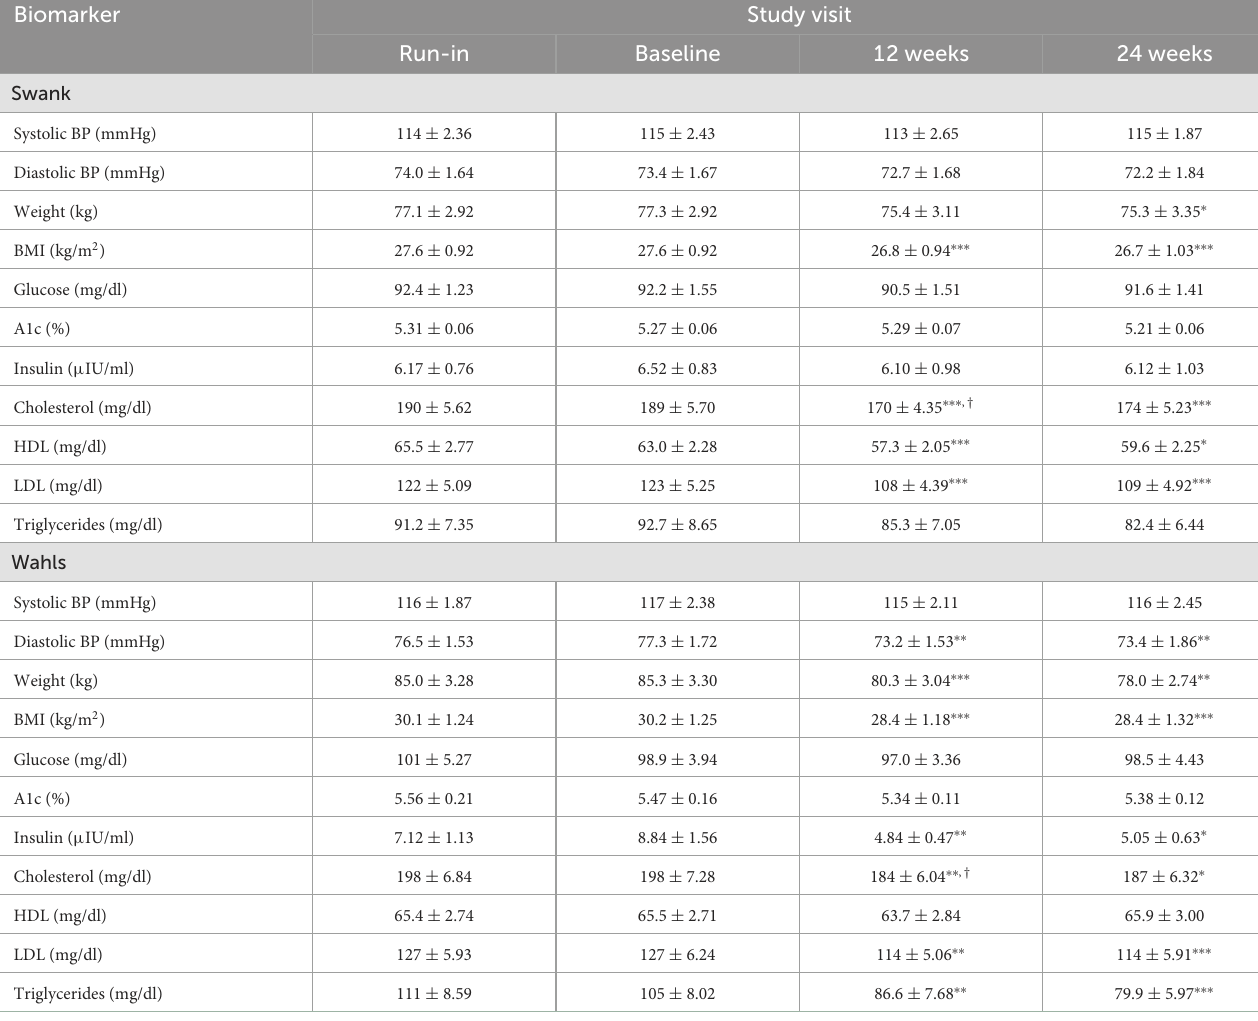
TABLE 2 Metabolic risk factor values among participants with RRMS assigned to the Swank or Wahls dietary interventions. Biomarker Study visit Run-in